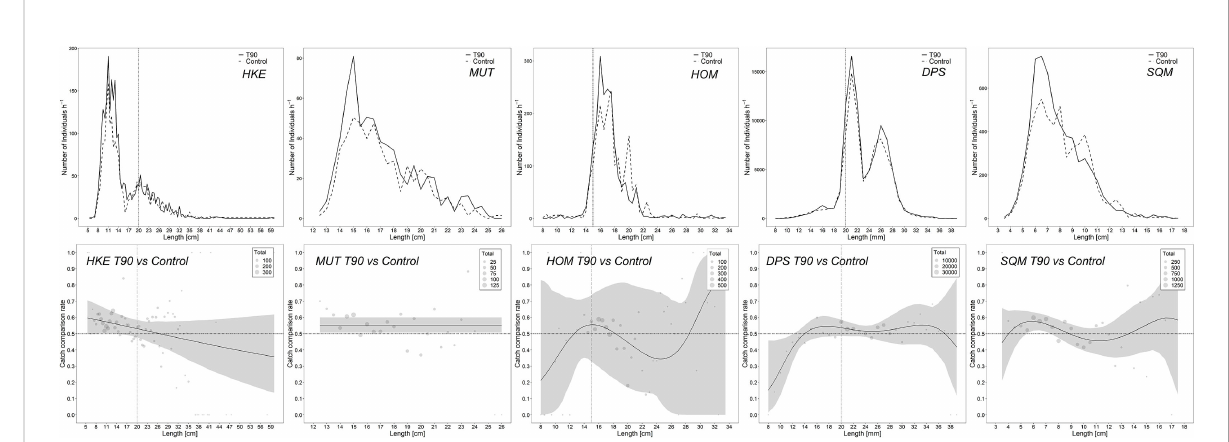
FIGURE 7 Length frequency distributions (above) and modelled catch comparison rates (below) of the T90 extension and the CTRL. HKE: M. merluccius ; MUT: M. barbatus ; HOM: T. trachurus ; DPS: P. longirostris ; SQM: I. coindetii . Black dotted vertical lines correspond to the MCRS of each species, if any. In the catch comparison graphs, the point-dashed horizontal line at 0.5 represents the point at which both gears have equal catch rates. The solid black line corresponds to the modelled catch comparison while the grey area is its 95% con fi dence interval. Dots corresponds to the individual proportions retained and the size is proportional to the total individual of each size